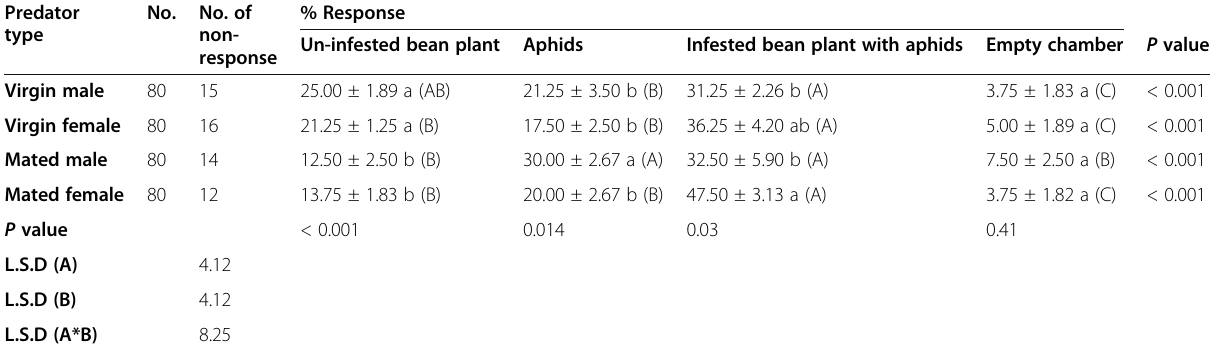
Table 1 Percentage of response ± SE of virgin and mated male and female of Coccinella undecimpunctata to different odor sources, tested in a 4-arm olfactometer (single individual experiment) Predator type